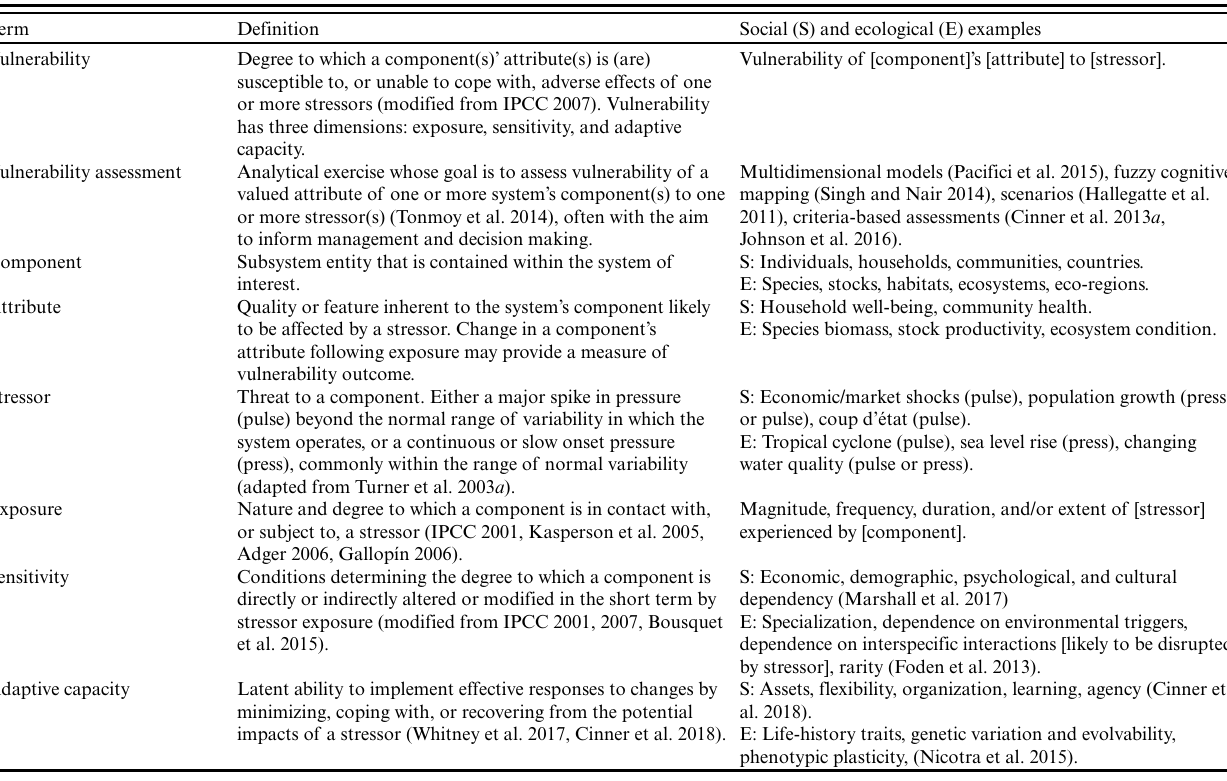
Table 1 . Glossary of terms with definitions adapted from the primary literature and illustrative examples from social (S) and ecological (E)